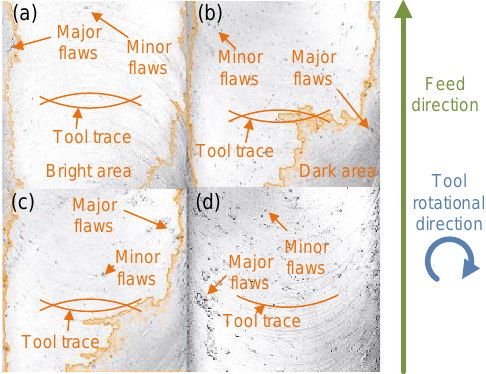
Figure 4. Surface textures of work piece micromilled under different coolants and methods. ( a ) Using Isopar H in MQCL; ( b ) using ethyl alcohol in MQCL; ( c ) using distilled water in MQCL; ( d ) under a dry-milling condition.